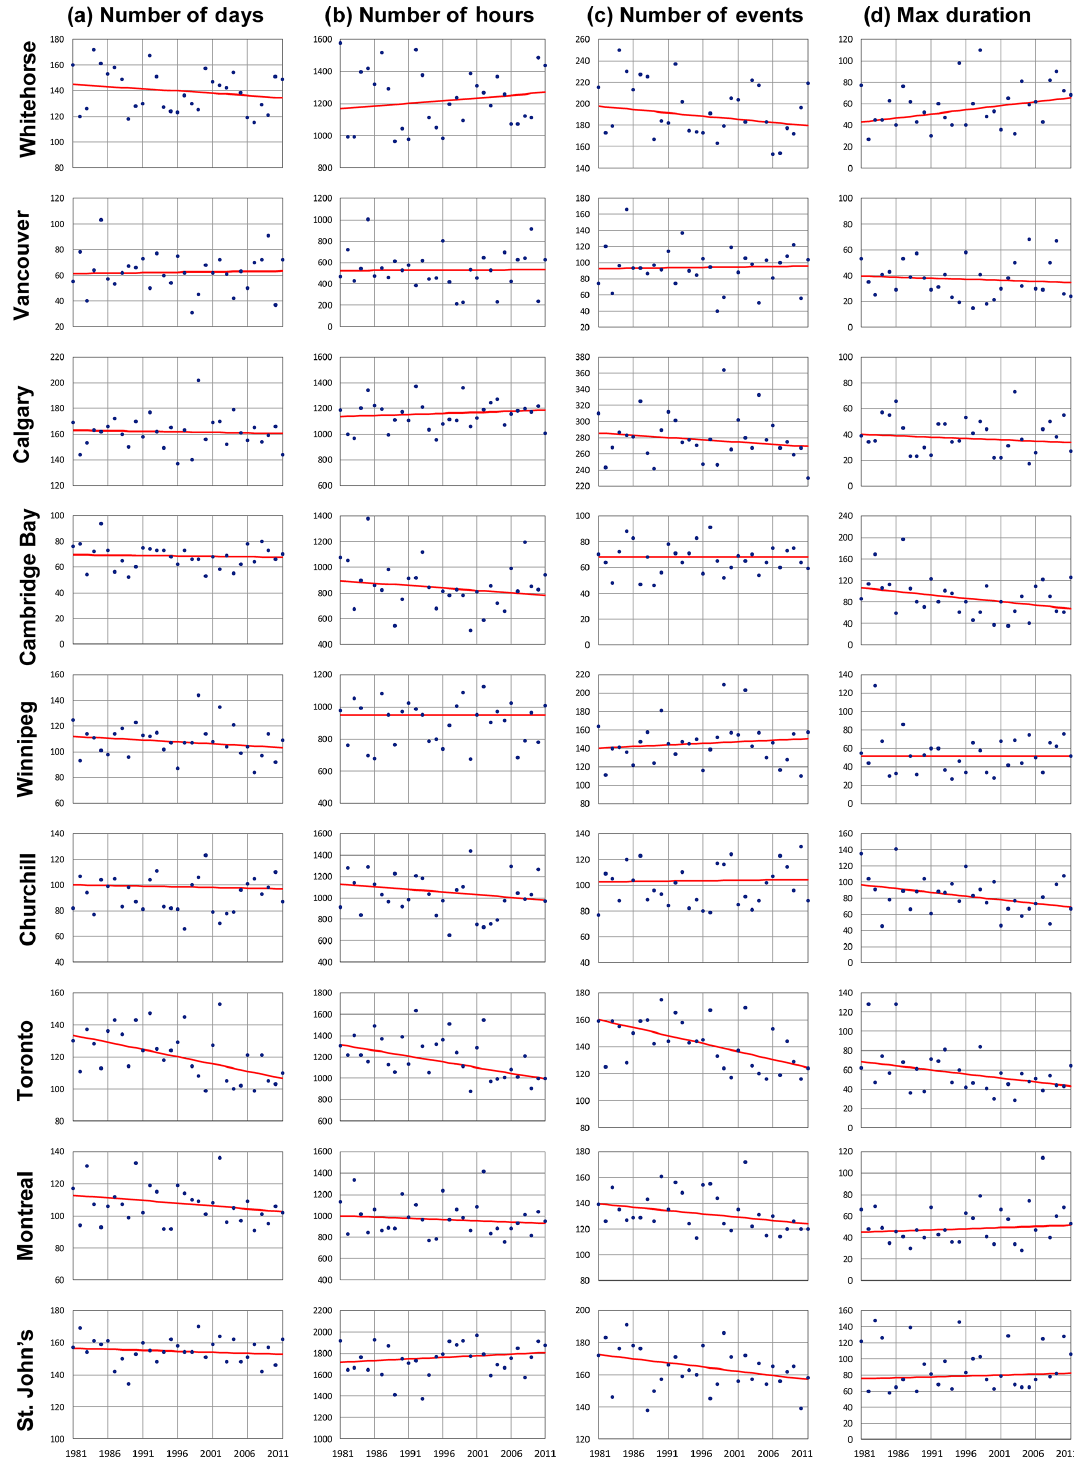
Figure 8. The 1981–2011 values of the average (a) annual number of days, (b) annual number of hours, (c) annual number of events, and (d) annual maximum duration (in hours) during near-0 ◦ C ( − 2 ≤ T ≤ 2 ◦ C) conditions for the nine selected locations in Canada. Linear trend lines are superimposed in